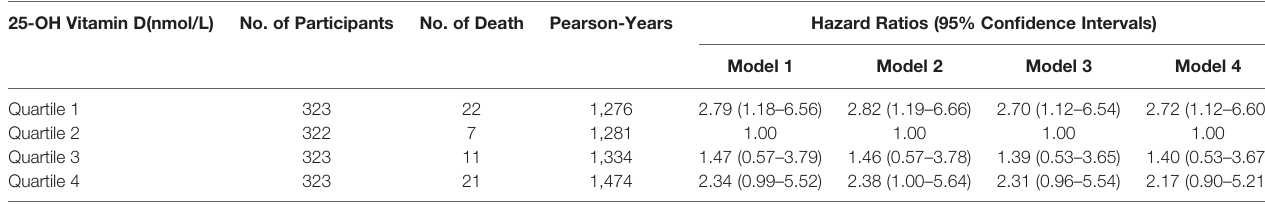
Model 1 adjusted for age and sex; Model 2 adjusted for age, sex, insurance status, smoking, and alcohol drinking; Model 3 adjusted for age, sex, insurance status, smoking, alcohol drinking, duration of diabetes, systolic blood pressure, HbA1c, eGFR, LDL cholesterol, history of CVD, use of anti-platelet agents, anti-hypertensive drugs, glucose-lowering agents, and cholesterol-lowering agents statins; Model 4 adjusted for age, sex, insurance status, smoking, alcohol drinking, duration of diabetes, systolic blood pressure, HbA1c, eGFR, LDL cholesterol, history of CVD, use of anti-platelet agents, anti-hypertensive drugs, glucose-lowering agents, cholesterol-lowering agents statin, and